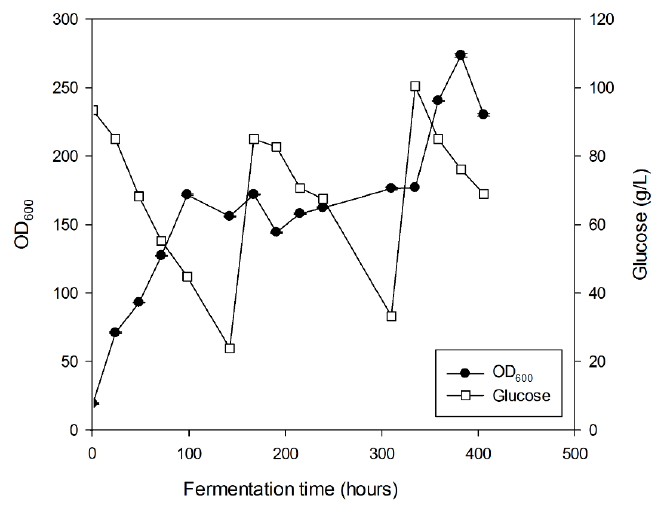
Figure 5. Glucose consumption and optical density for the 3-L fermentation with Starmerella bombicola CYP1BMR using ethyl palmitate.